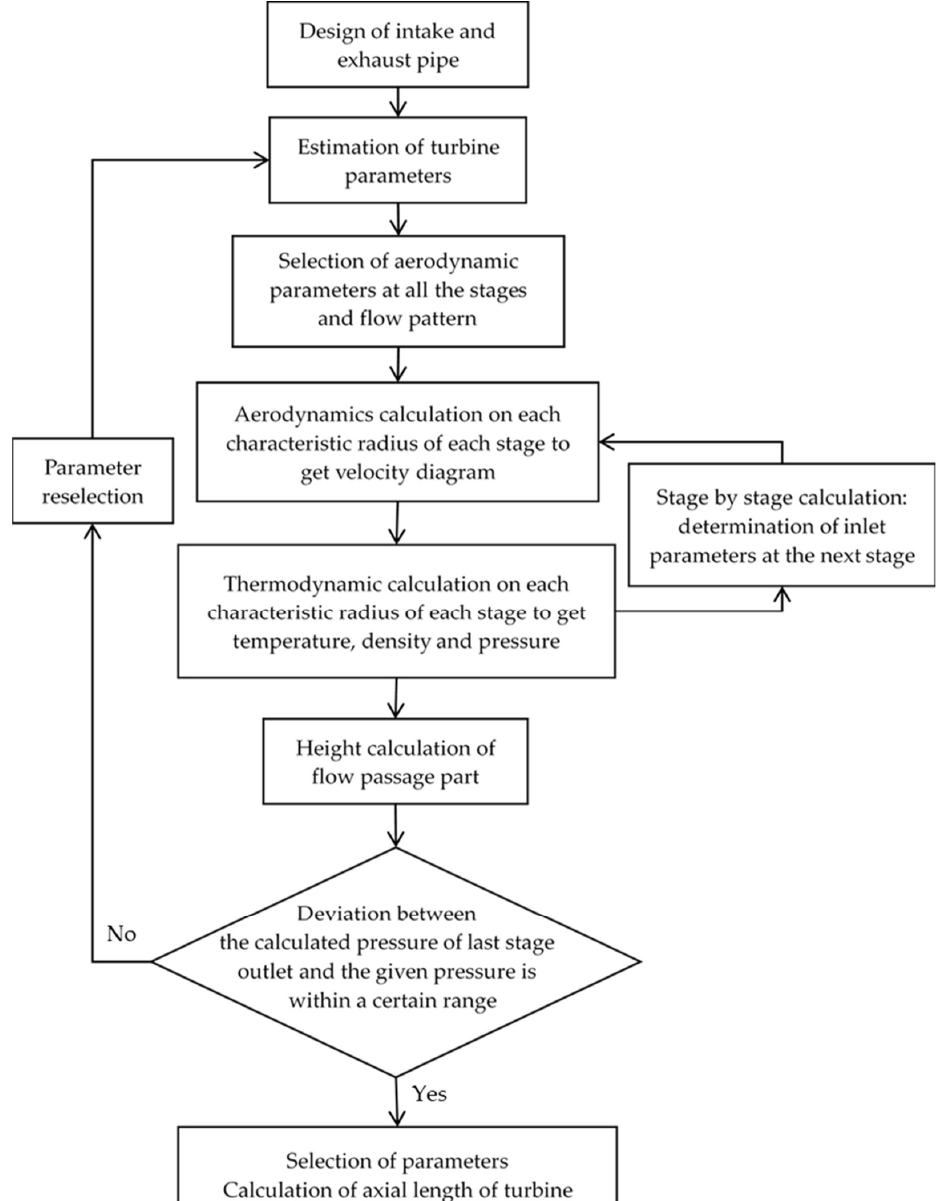
Figure 6. Algorithm of the turbine aerothermodynamics